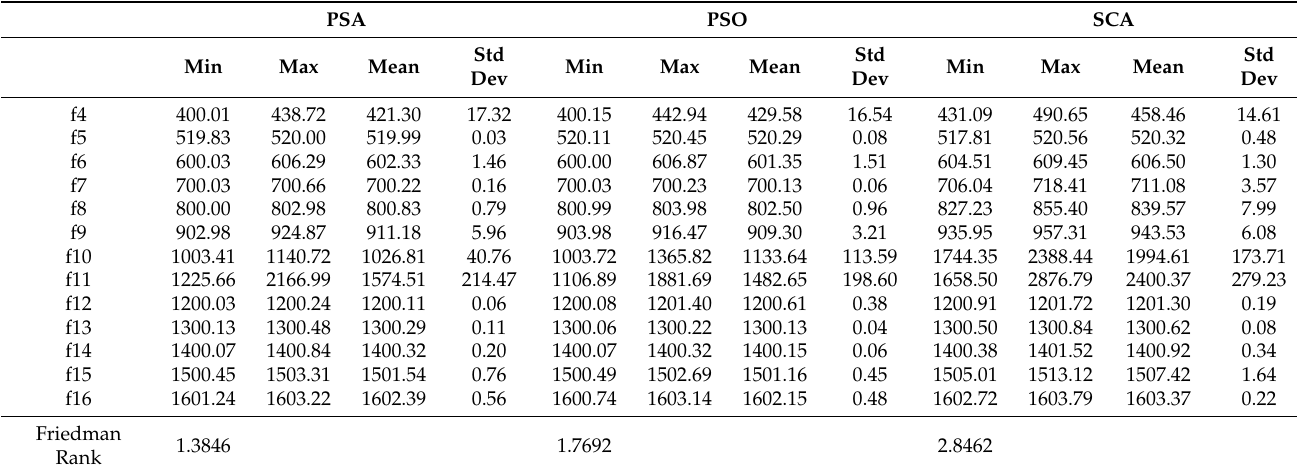
Table 4. Performance of PSA vs PSO and